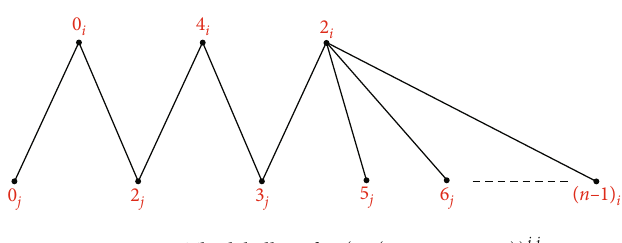
1, 0, 0, n − 4 ÞÞ i , j : 4 ð